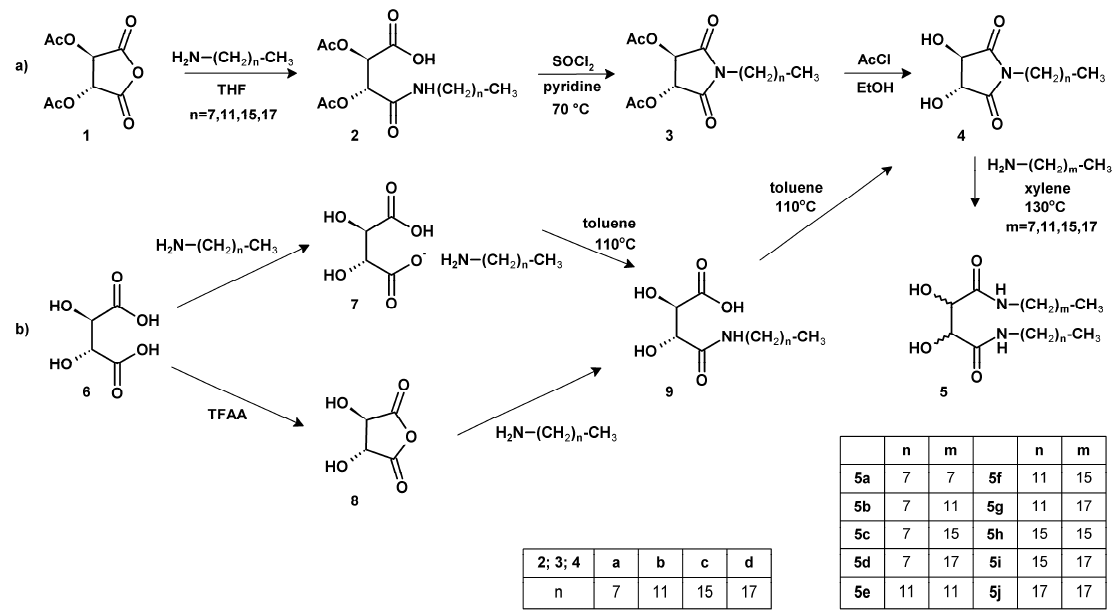
Scheme 1. Synthesis of tartaric acid diamides